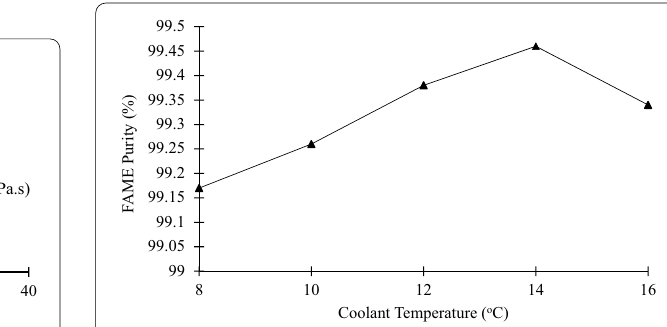
Fig. 9 Graph of FAME Purity against coolant